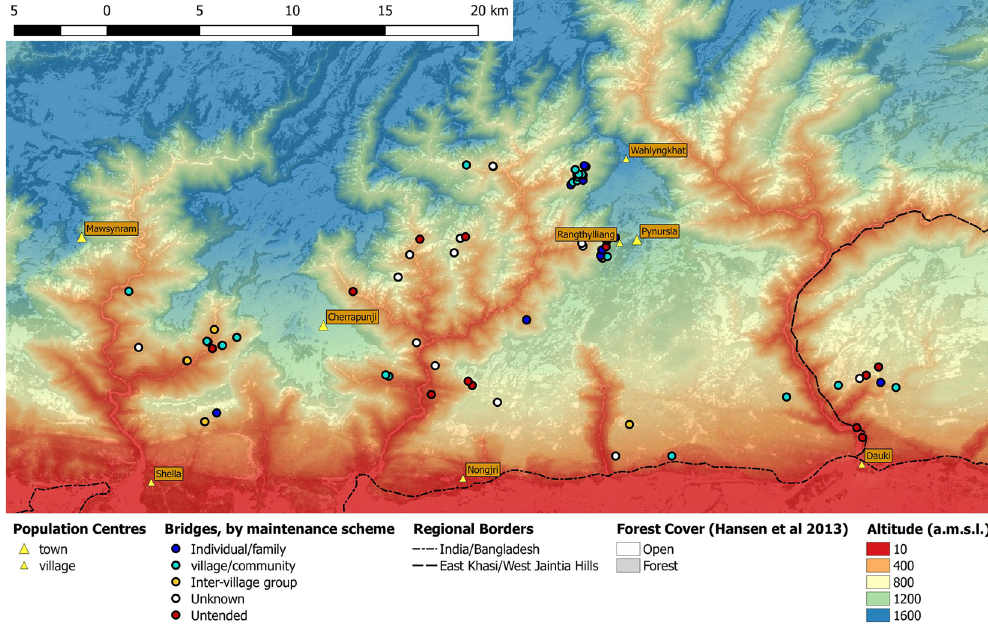
Figure 3. Map of the Khasi and Jaintia Hills illustrating bridge locations maintenance types, altitude (based on SRTM data according to Jarvis et al . 33 and forest cover (as mapped by Hansen et al . 34 ).